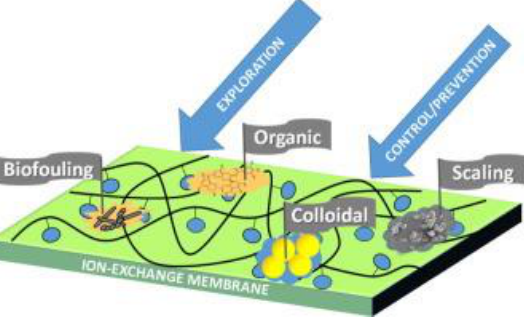
Figure 2. Types of fouling. Reprinted with permission from [28]. Copyright © 2015 Elsevier B.V.